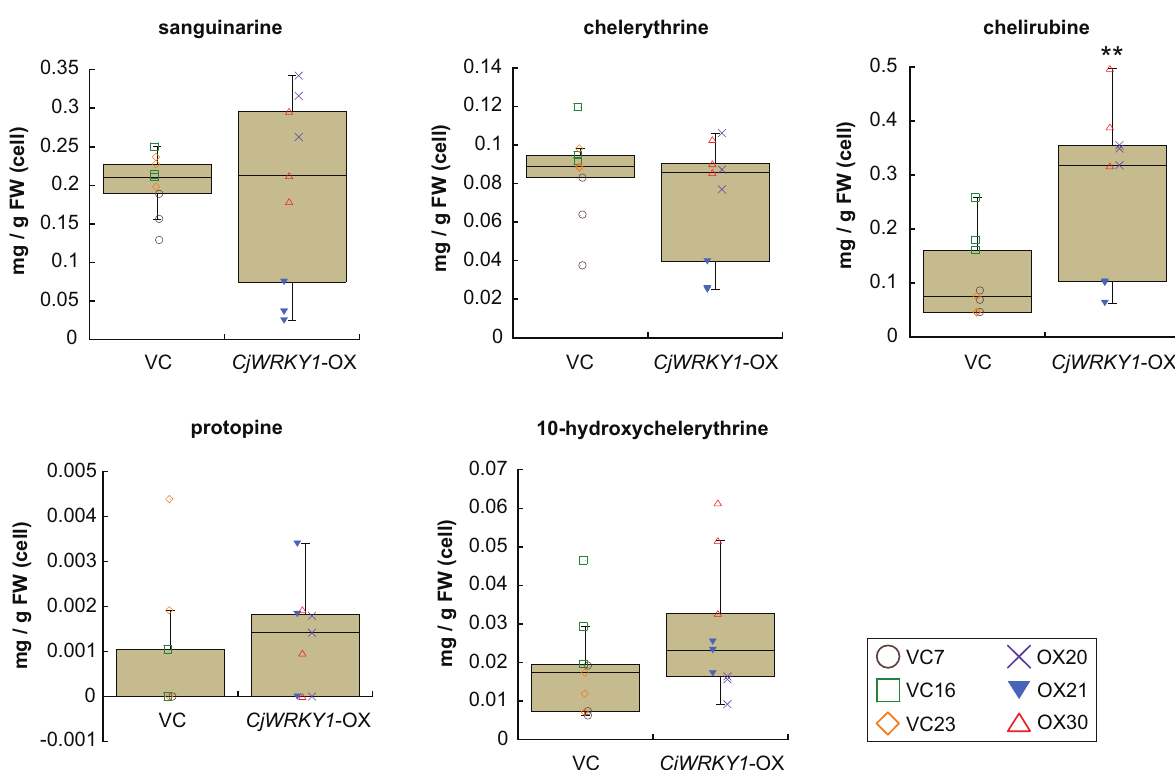
Fig 6. The accumulation of representative BIAs in transgenic cells of California poppy. The contentsof sanguinarine, chelerythrine, chelirubine, protopine, and10-hydroxychelerythrine in cell extract werecalculated usingthe standard curveof sanguinarine. Ninebiological replicateswereusedof cell line.Asterisks indicatesignificant differences from VC cells( ** P < 0.01, two-tailed pairedStudent’s t -test).